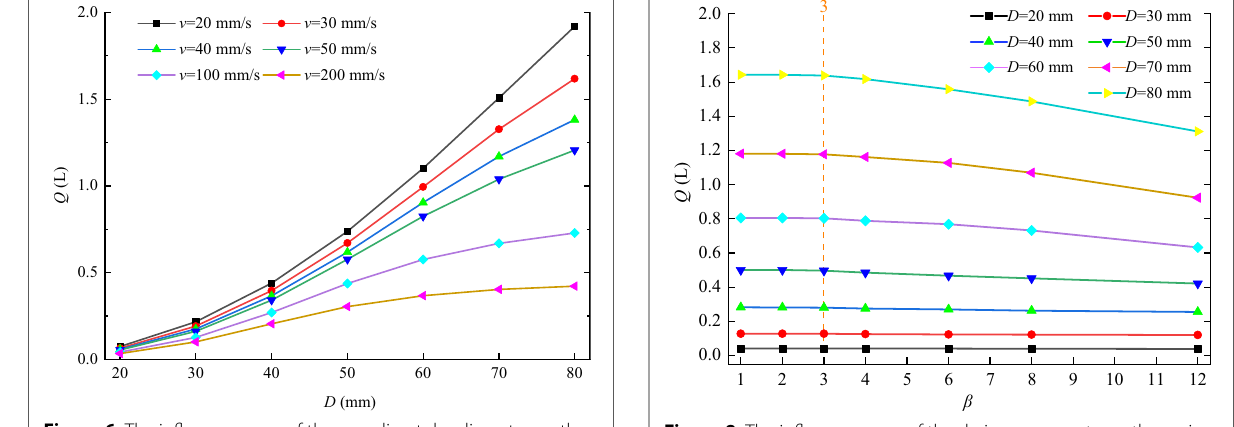
Figure 8 The influence curve of the drainage area rate on the coring